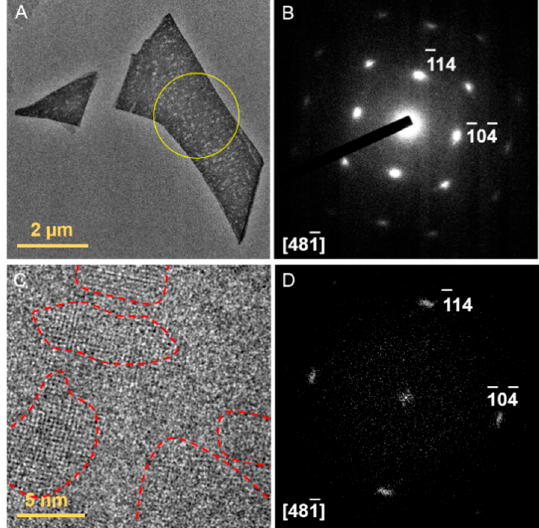
Figure 5. Characterization of an air-damaged sample. ( A ) Low magnification image of damaged sample and ( B ) its corresponding SAED, the yellow circle in ( A ) denotes the selected area; ( C ) The HRTEM image and ( D ) its corresponding FT pattern. The red dot lines outline the particles of PbI 2 .